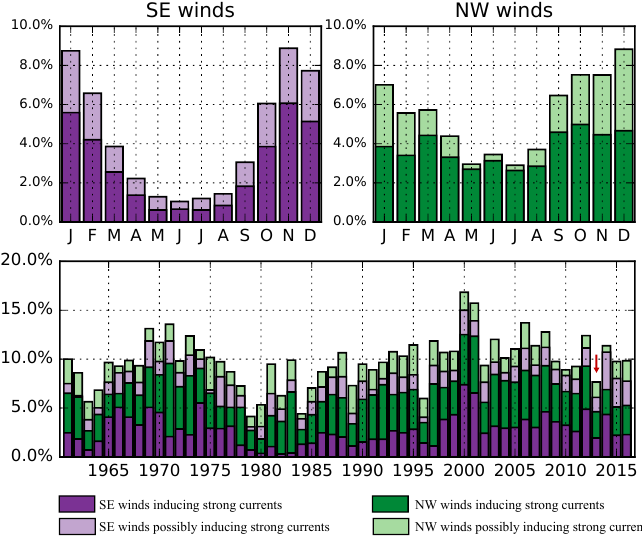
Figure 12. Monthly occurrences of winds over 10 ms − 1 from directions known to induce strong currents from years 1961–2016. Yearly occurrence of the favourable directions is shown in the bottom-most panel. Our study year of 2013 is pin pointed with a red arrow. Directions in question are visualised in Figure